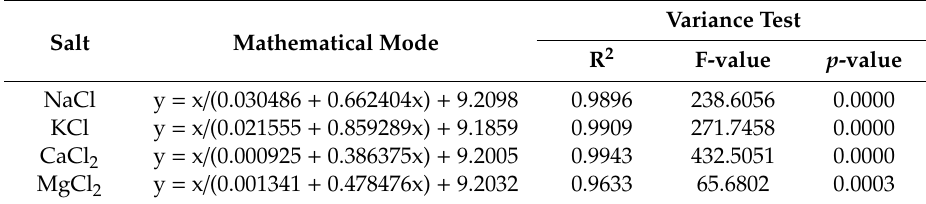
Table 1. Effect of saline xanthan gum on the K/S value. Table 1. E ff ect of saline xanthan gum on the K / S value.